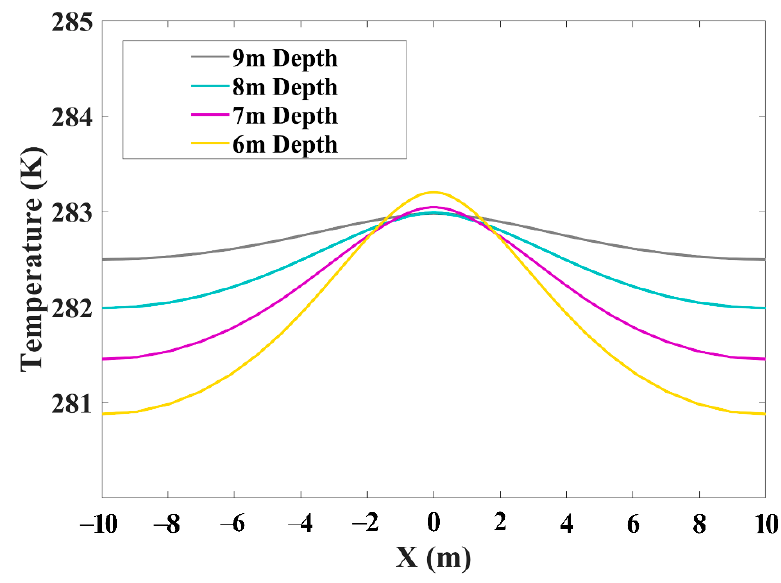
Figure 11. Temperature distribution at different depths in the case of 341 K oil temperature.